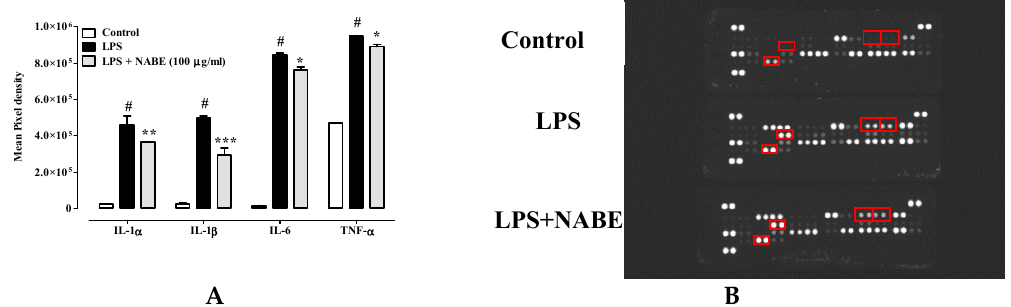
Figure 2. ( A ) Inhibitory e ff ect of Nepeta asterotricha n- butanolic extract (NABE) on inflammatory cytokines levels [i.e., IL-1 α , IL-1 β , IL-6 and TNF- α ] in the cell medium of J774A.1 macrophages stimulated with lipopolysaccharide (LPS, 1 µ g / mL) for 24 h. NABE, used at the concentration of 100 µ g / mL, were added to the cell media 30 min before LPS stimulus. ( B ) Representative images of each array (untreated, treated with LPS and LPS + NABE). Results are expressed as mean ± SEM of three experiments (in triplicates). # p < 0.001 vs control; * p < 0.05, ** p < 0.01 and *** p < 0.001 vs LPS alone.